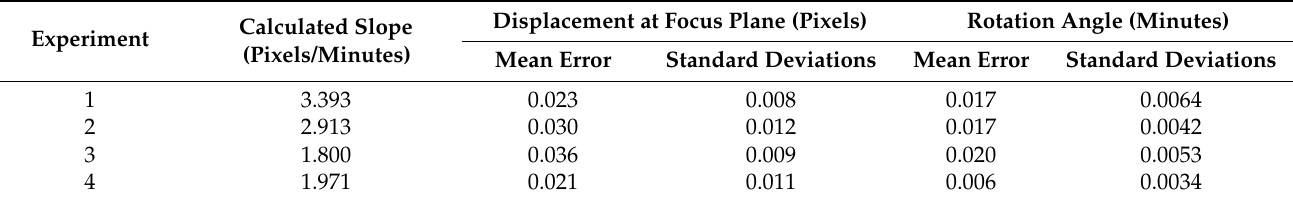
Table 2. Comparison of error results from different experiments.